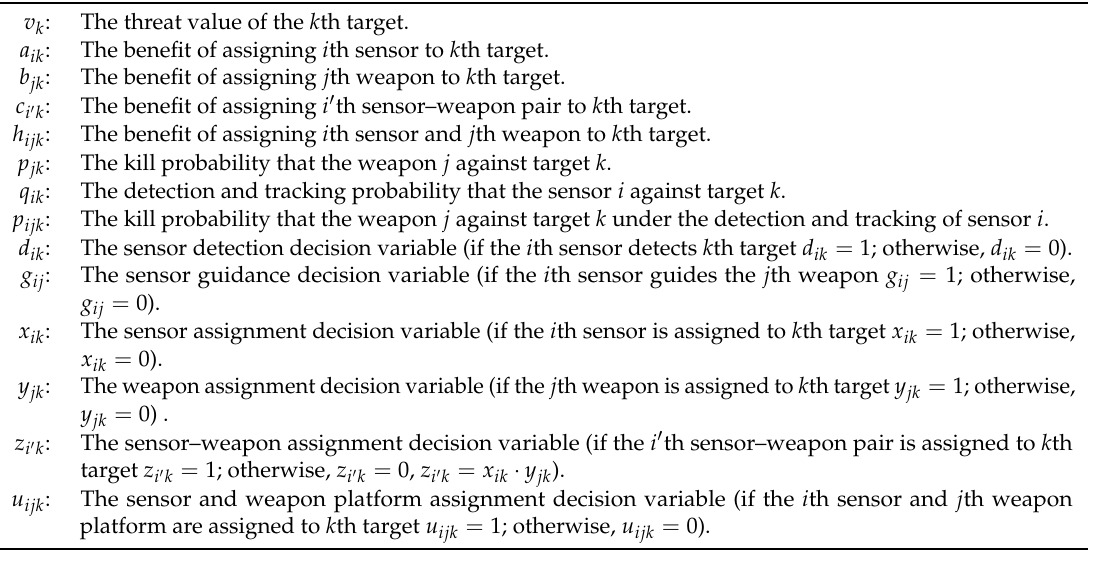
Table 1. Variables